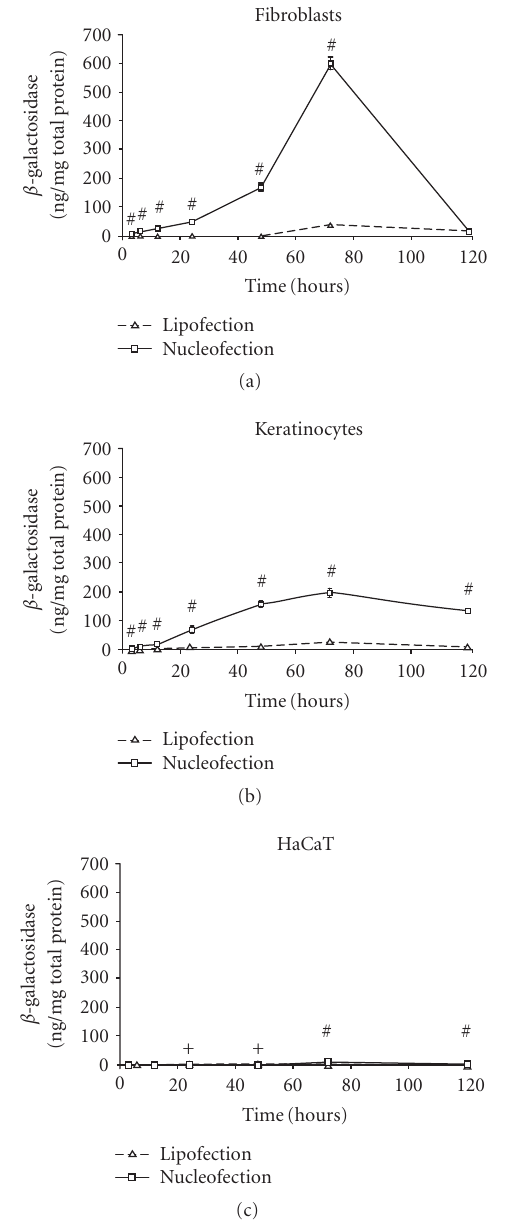
Figure 1: Transfection e ffi cacy . Reporter gene expression in epithe- lial cells (5 days followup). FuGENE6-enhanced lipofection (open triangle) and Amaxa nucleofection techniques (open square) were compared. Each measured value including the HaCaT curve was upon background levels. #: ( P < . 05) nucleofection versus lipofec- tion, +: ( P < . 05) lipofection versus nucleofection. Data are dis- SEM. played as mean (cid:0)